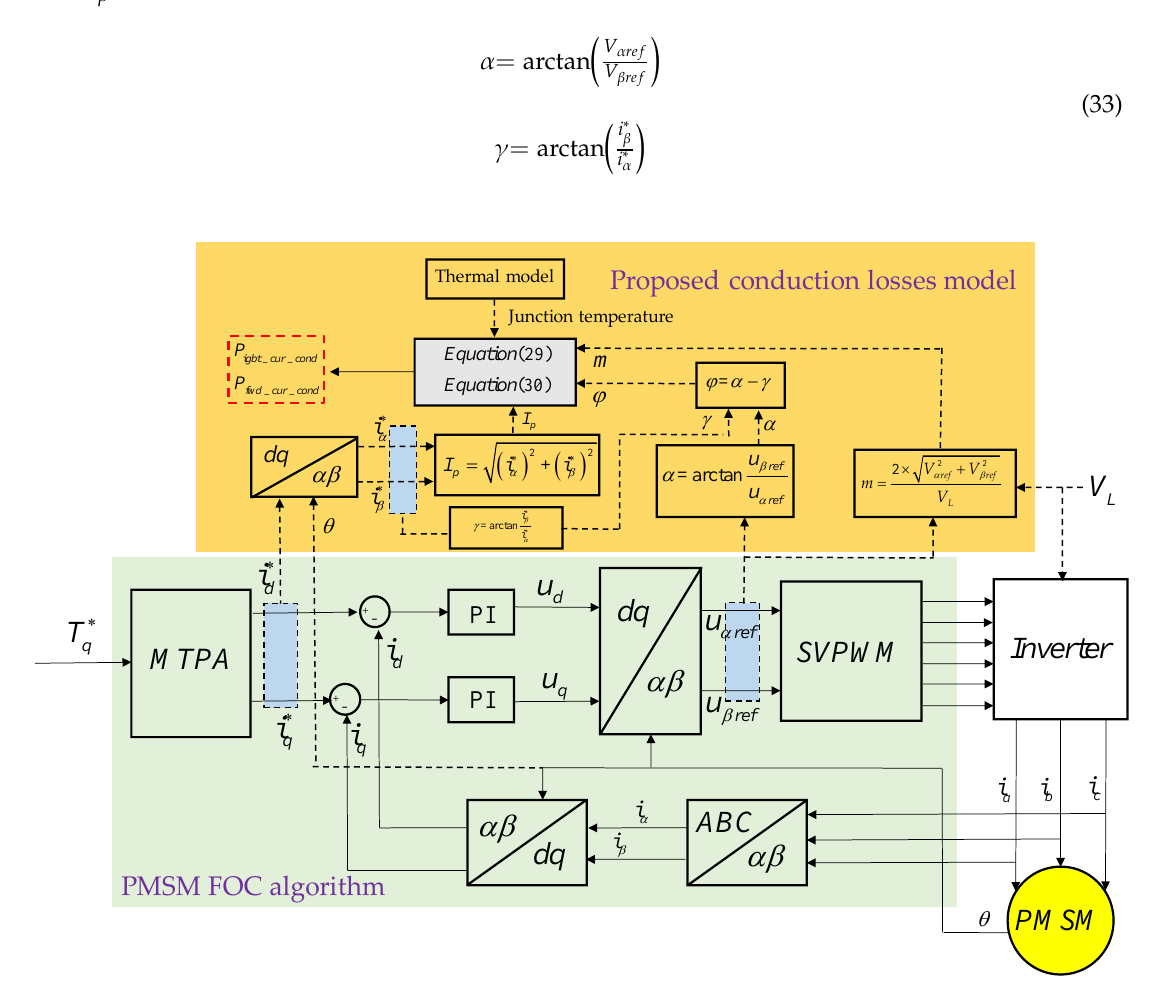
Figure 5. Proposed conduction losses model.